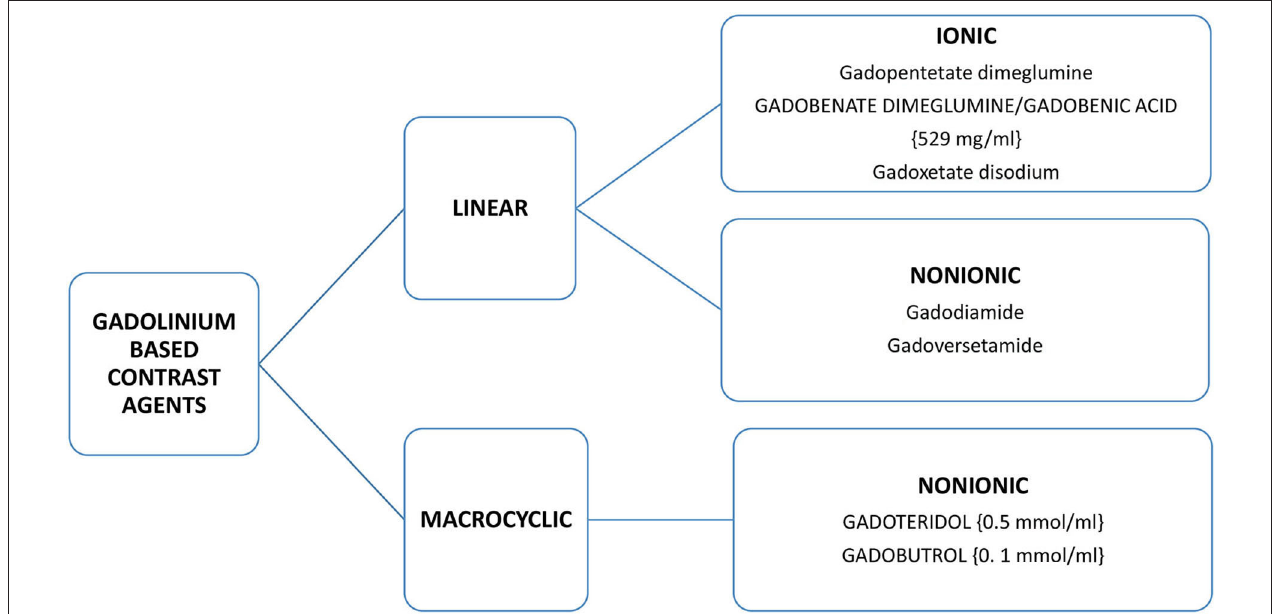
FIGURE 1 | Classification of gadolinium based contrast agents (GBCAs)(-concentration of available GBCAs-).